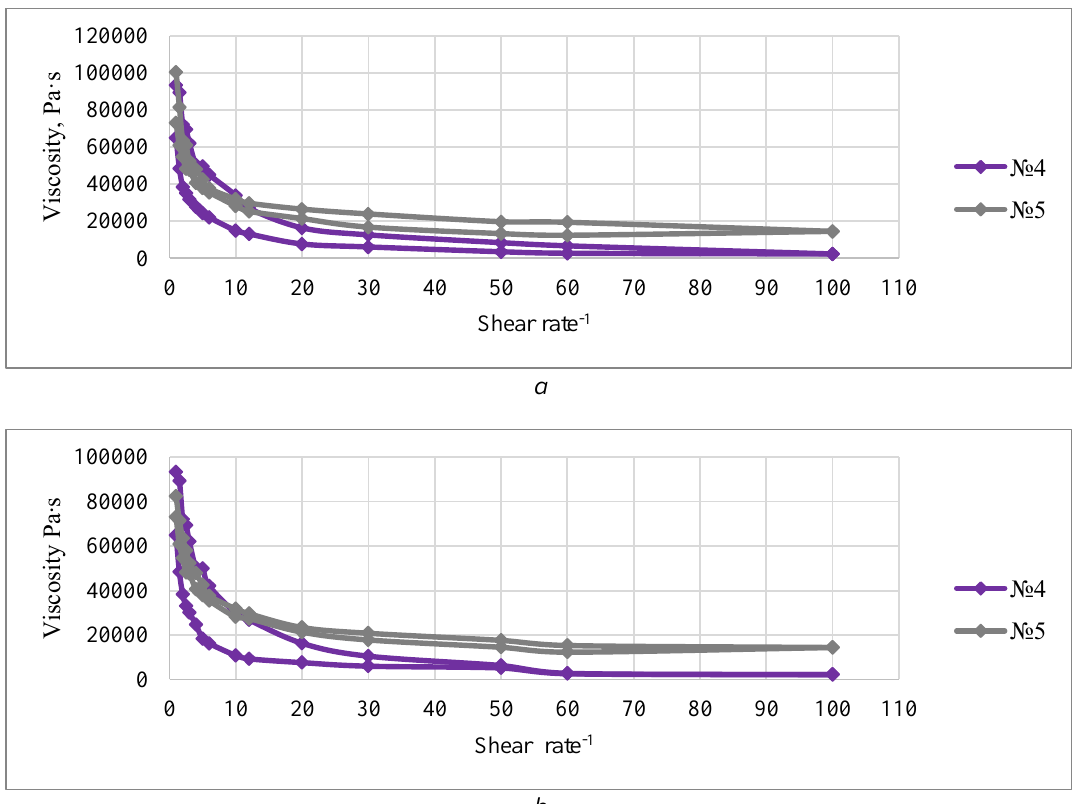
Fig. 4. Dependence of dynamic viscosity on shear stress in samples of drugs in soft dosage forms with nanoparticles of silver and gold: а – after preparation; b – after 24 months of